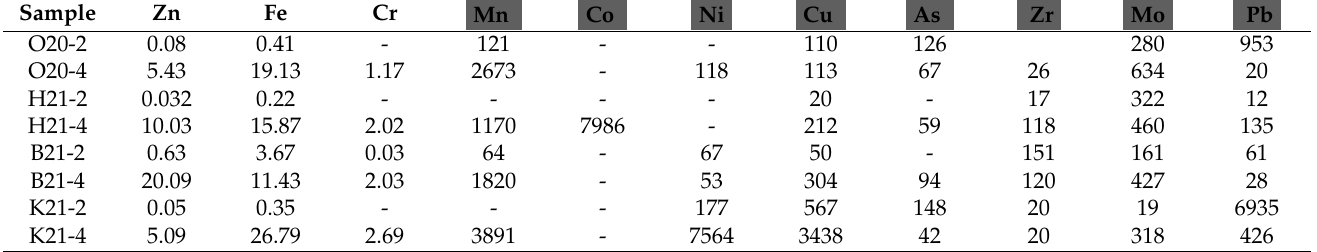
Table 8. ED-XRF analysis for Zn, Fe and Cr (wt.%) of leaching residues and precipitates after refining using ammonia (an average of three measurements). Other elements (with grey color ) are in wt.